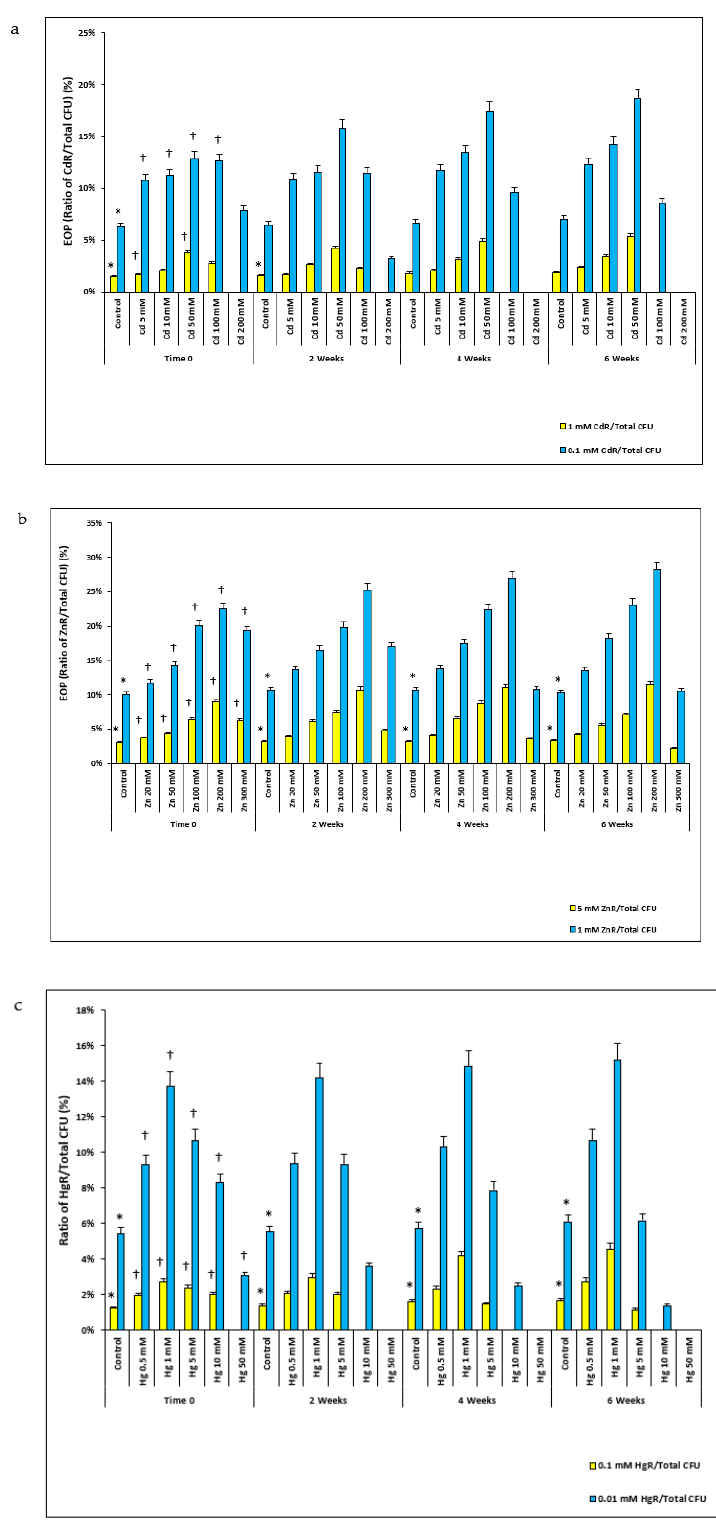
Figure 1. Mean ratios of HMR EOP plotted at 2-week intervals, selected on plates with two concentrations of HM. ( a ) Mean ratios of CdR EOP. ( b ) Mean ratios of Zn resistant EOP. ( c ) Mean ratios of Hg resistant EOP. * p < 0.05 compared to the HMR/total bacterial CFU ratios in HM-spiked microcosms; † p < 0.05 compared to the HMR/total bacterial CFU ratios in the same HM-spiked microcosms at the 6-week